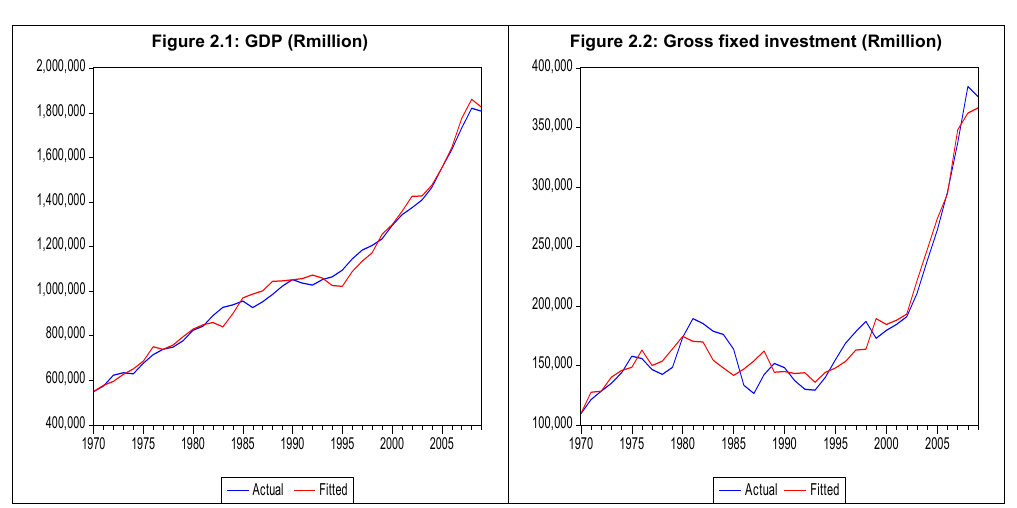
Figure 2.1: GDP (Rmillion) Figure 2.2: Gross fixed investment